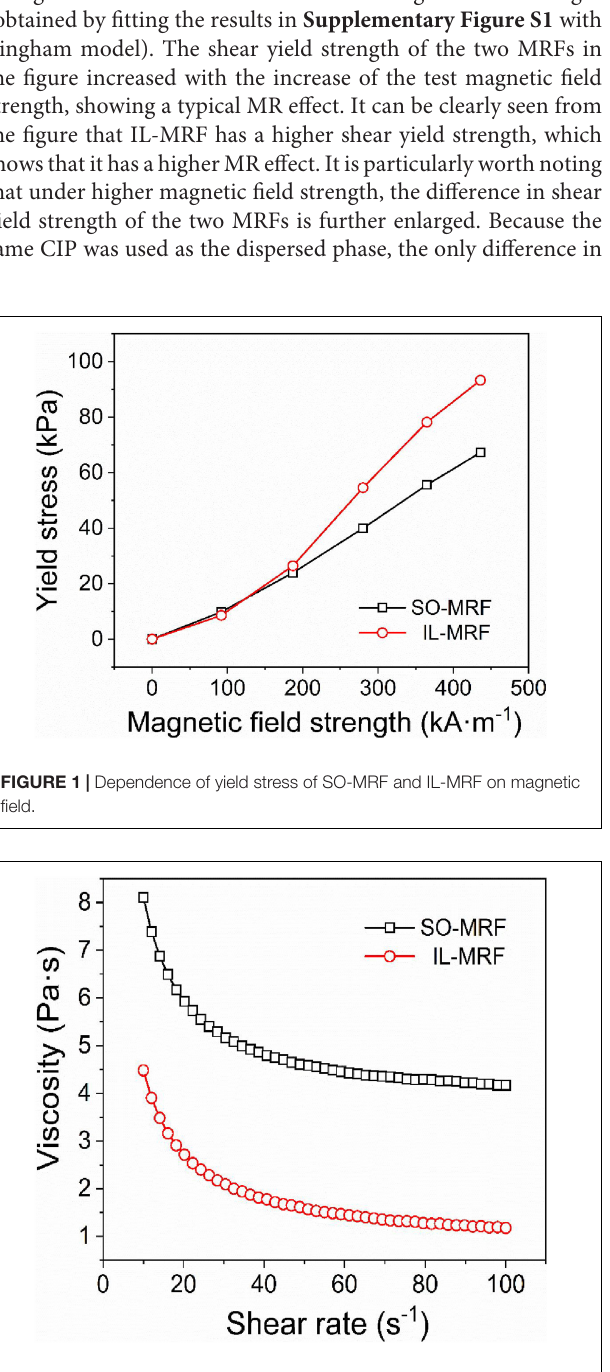
Frontiers in Materials |